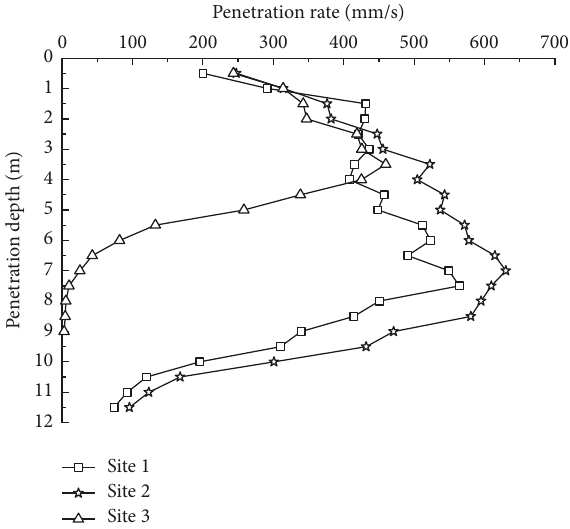
Figure 10: Penetration rate of piles driven in site 2 versus penetra- tion depth.